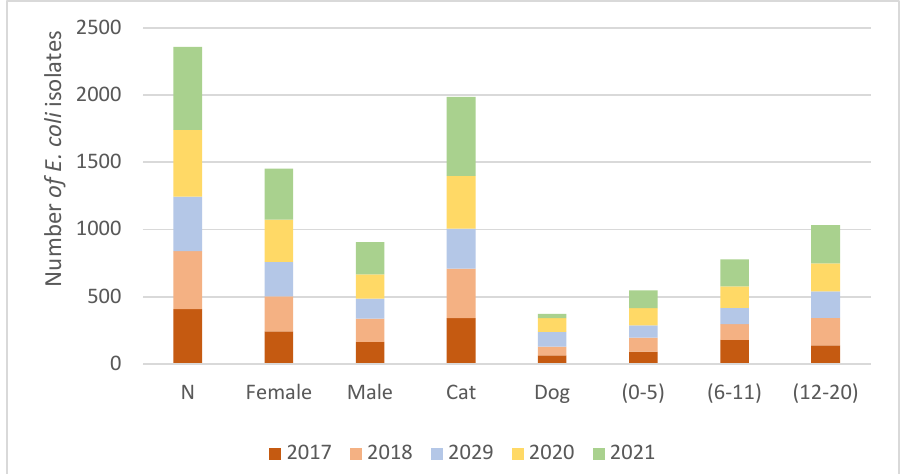
Figure 3. Several E. coli isolates were found in every year of the study (2017–2021). The species (dog and cat), sex (female and male), and age (0–5, 6–11, and 12–20 years) in which E. coli was isolated by year.